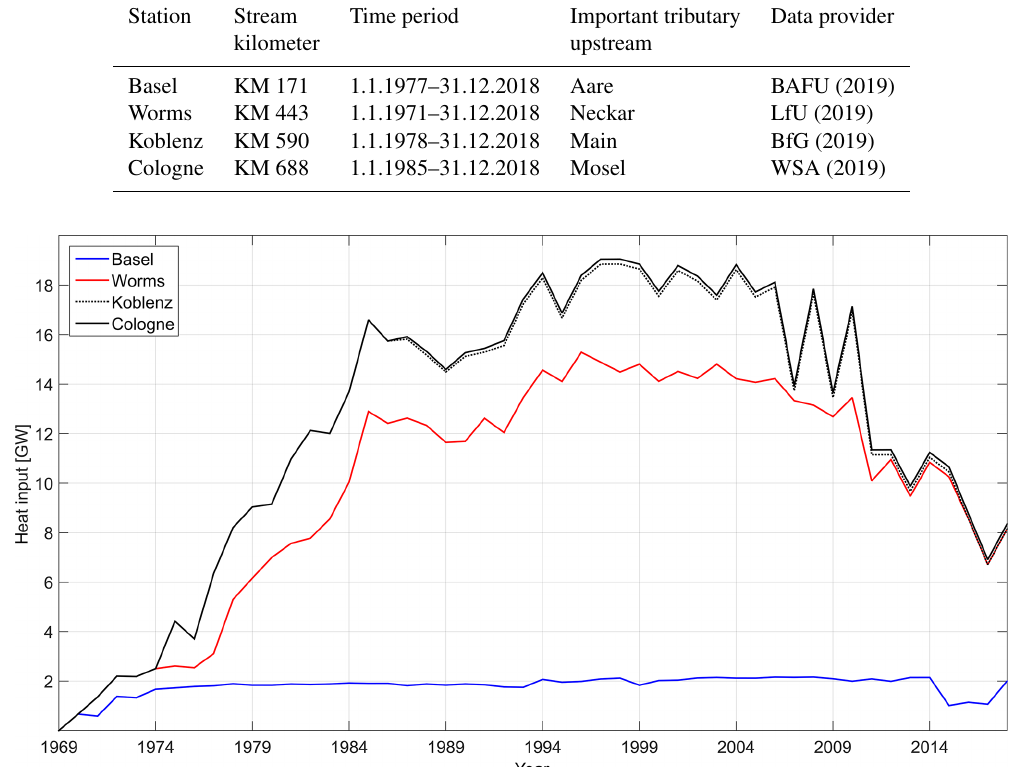
Figure 1. Heat input by upstream nuclear power plants (NPPs) from 1969 to 2018 at each monitoring station.